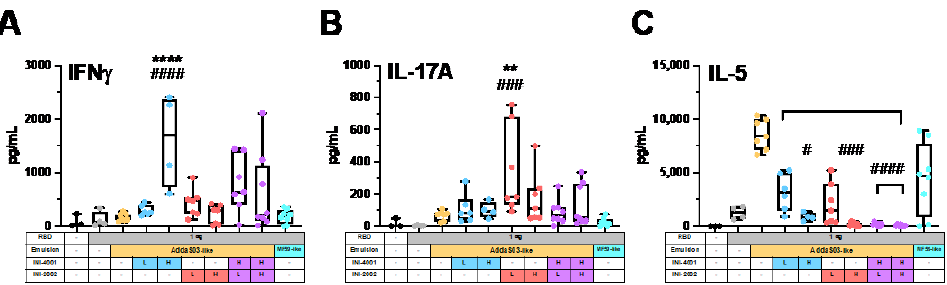
Figure 7. Addition of TLR4 or TLR7/8 agonists to AddaS03-like emulsions significantly skewed away from Th2-type cytokine profiles in the draining lymph node (DLN). Fourteen days post-secondary immunization, lymphocytes were isolated from the DLN, grown ex vivo, and stimulated with SARS-CoV-2 RBD for 72 h. RBD-specific ( A ) IFN γ , ( B ) IL-17A, and ( C ) IL-5 were measured in the cell supernatant for each group. A one-way ANOVA with a post hoc Tukey’s test for multiple comparisons demonstrated significant differences in group means when compared to the AddaS03-like (** p < 0.01, **** p < 0.0001) or MF59-like (# p < 0.05, ### p < 0.001, and #### p < 0.0001) emulsions alone.